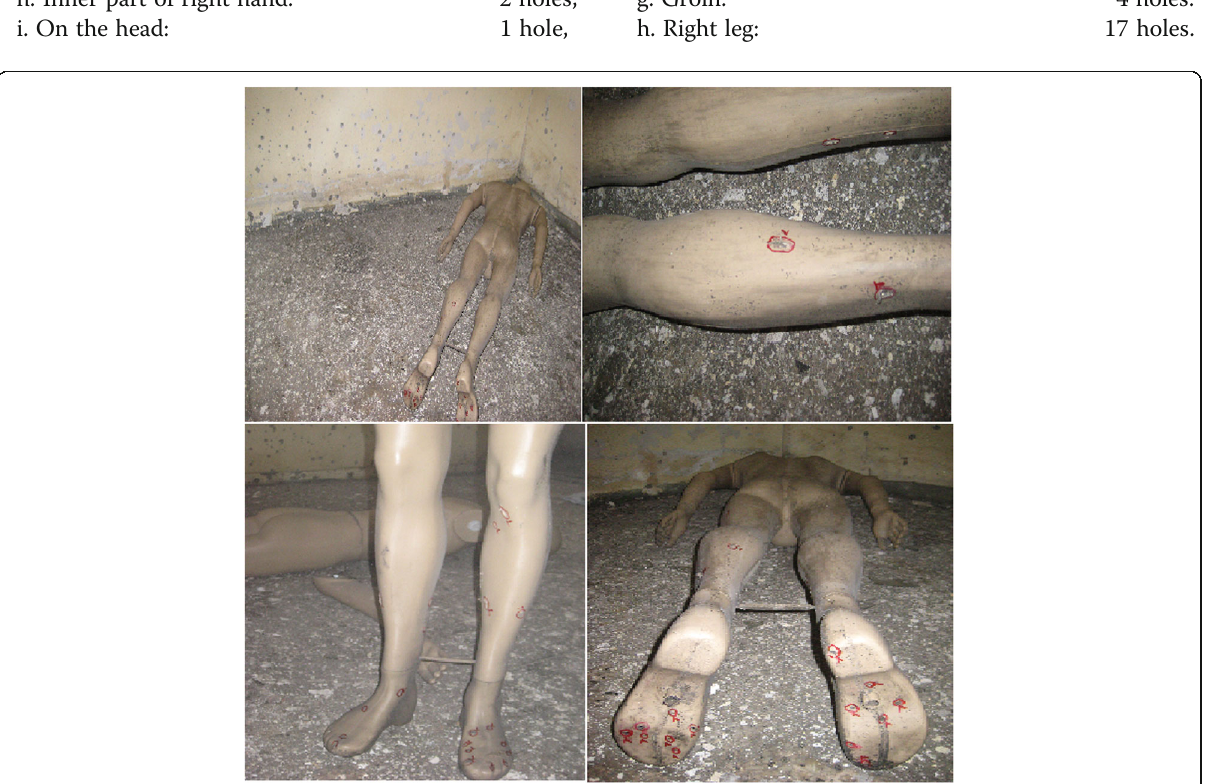
Fig. 14 Mannequin-2 (male-2) lied face down on left opposite corner after